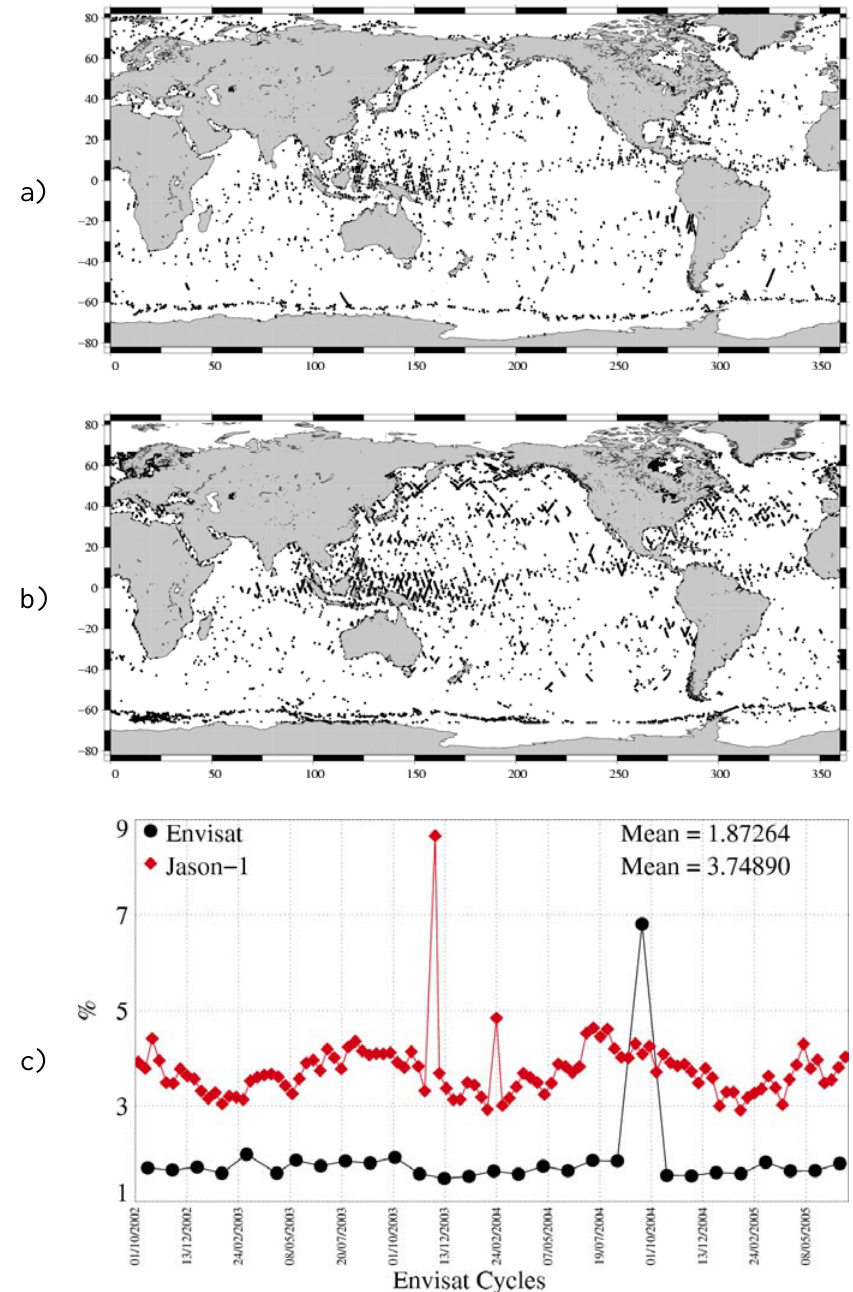
Figure 5. Comparison of Envisat edited measurement to Jason-1. Maps of rejected measurements, with the same editing procedure for: a) 10 days of Envisat cycle 38 b) the corresponding Jason-1 cycle